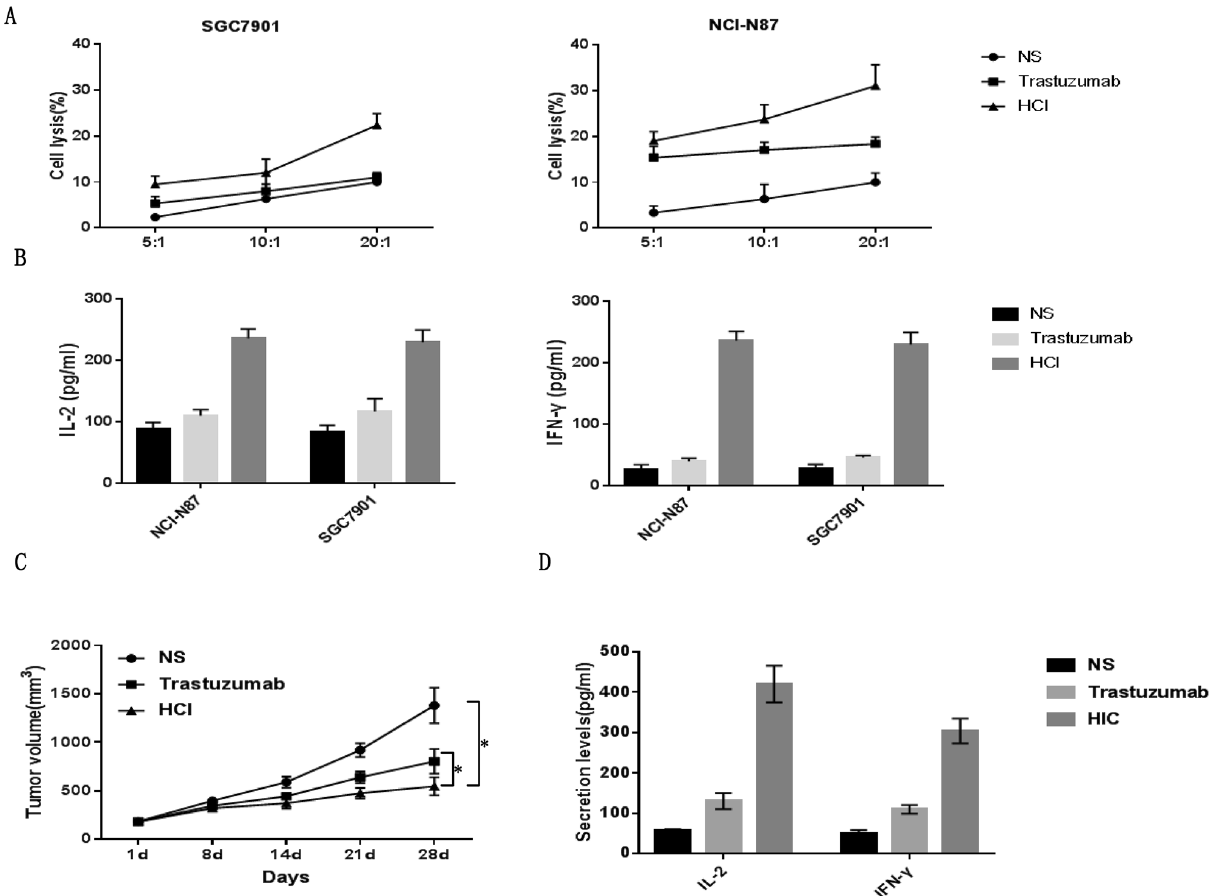
Figure 3. HCI fusion protein-induced immune cells lyse tumor cells both in vitro and in vivo. ( A ) Cytotoxic activity analysis of PBMCs induced by HCI fusion protein. NCI-N87 or SGC7901 cells cocultured with PBMCs at increasing ratios (5:1, 10: 1 and 20:1) in the presence of HCI fusion protein or trastuzumab and CCK-8 assays were used to detect target cell lysates. ( B ) In vitro cytokine secretion (IL-2, IFN-γ) of PBMCs cells analysis. PBMCs co-cultured with target cells at a 10:1 ratio were treated with HCI fusion protein or trastuzumab for 24 h, and ELISA was used for detection. ( C ) After the tumor volume of xenograft mice reached approximately 150 mm3, the mice were treated with standard doses once a week, and the volumes of xenograft mouse tumors were recorded for statistical analysis.(* p < 0.05). ( D ) After the mice were sacrificed, 100 μL of peripheral blood from treated mice was obtained for the in vivo cytokine secretion assay according to the ELISA kit